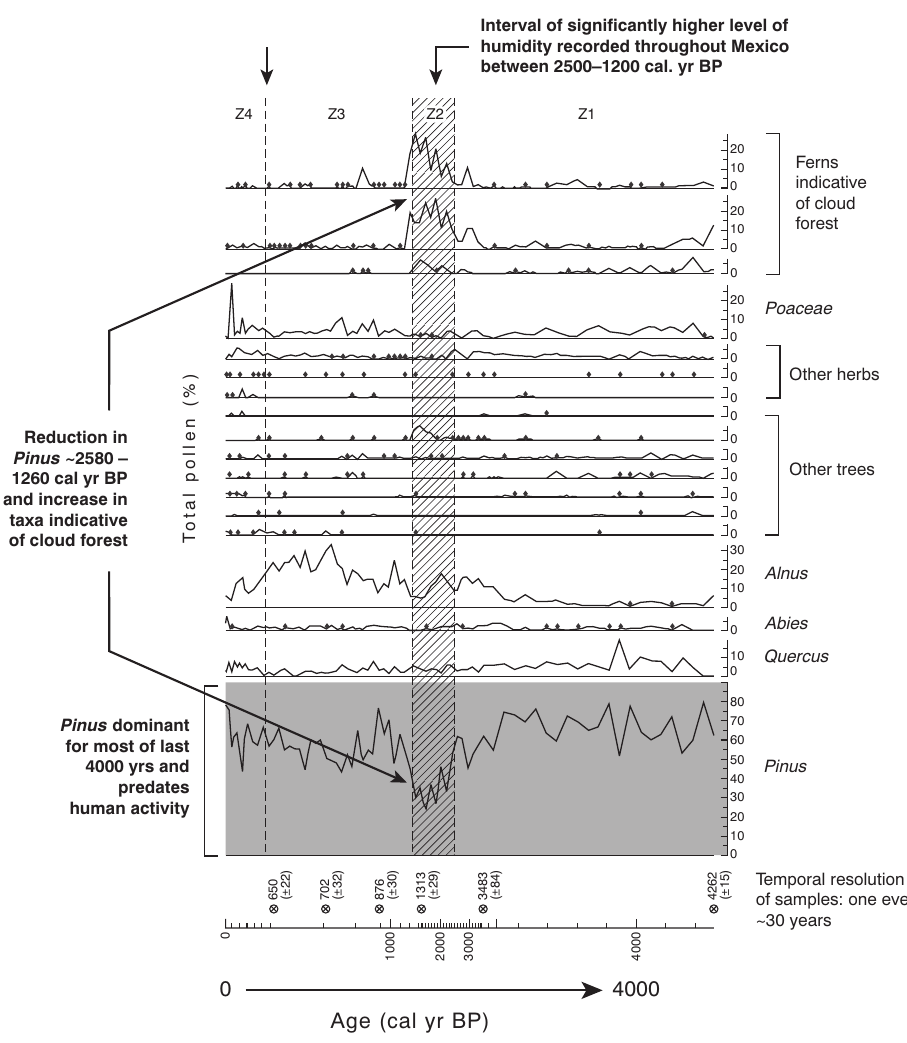
Fig. 1. Percentage pollen diagram of the pine-dominated forest in West-Central Mexico over the past 4200 years for total pollen sum, including spores of ferns. Ages are calibrated years BP (mean and 95% confidence interval of accuracy) (Redrawn from Figueroa-Rangel et al.,